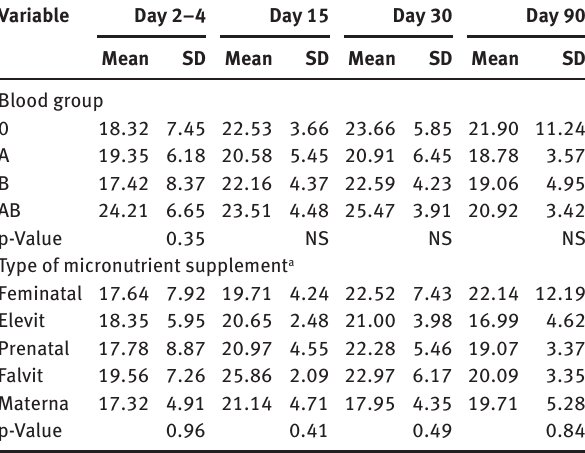
Table 3: Breast milk concentration of neopterin, nmol/L, depend- ing on maternal blood group and the use of various micronutrient